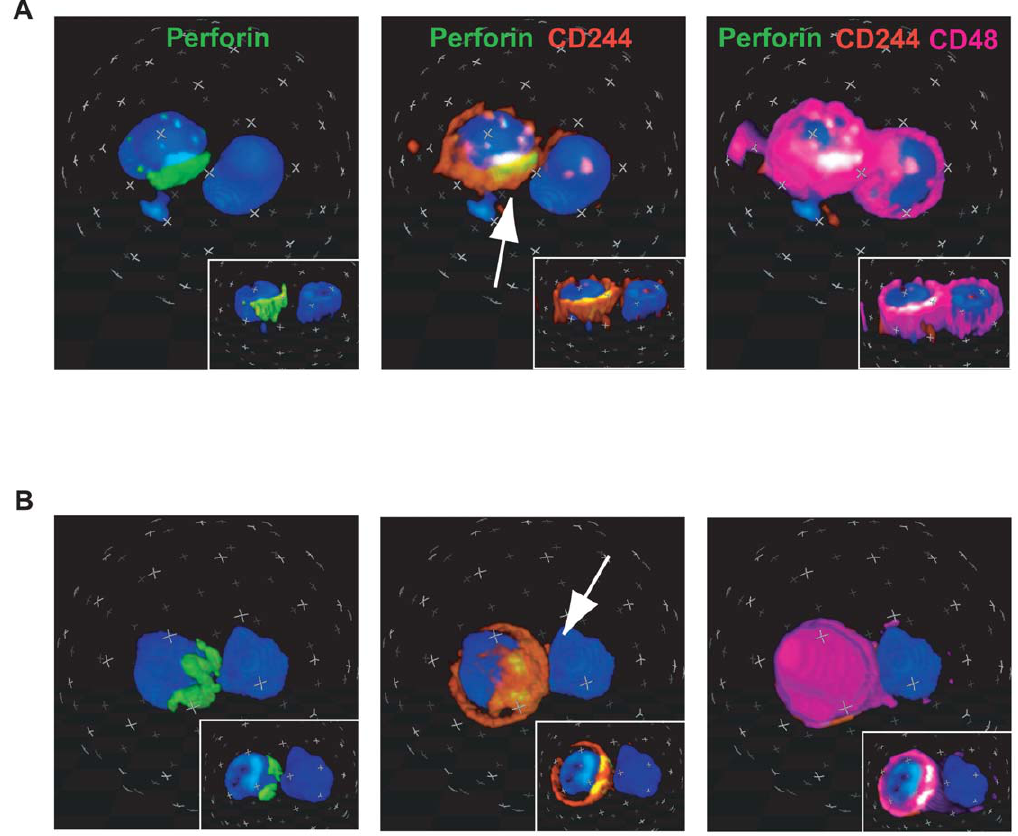
Figure 3. Distribution of CD244 in PBMCs of patients with HAM/TSP. After the culture for 8 hours, PBMCs were stained with antibodies against perforin, CD244 and CD48, and visualized through microscope. Two representative 3D images were shown in A and B. The image shows DAPI (blue), perforin (green), CD244 (orange) and CD48 (purple). In addition to DAPI and perforin (left), CD244 (middle) and CD48 (right) are merged. The white arrows indicate CD244 clustering at the cell contact area.